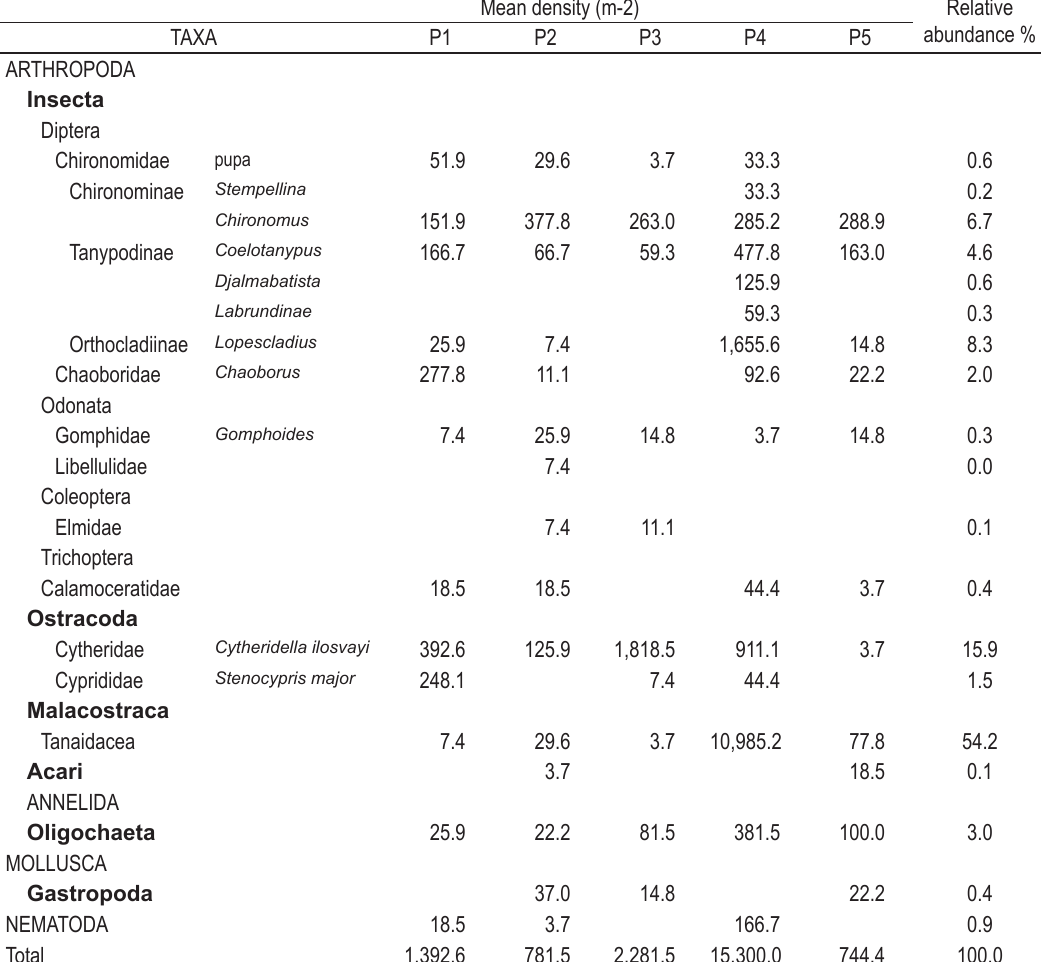
Table 2. Taxonomic composition, mean density of organisms at each sample site and relative abundance of aquatic invertebrates found in the sediment of Peri lagoon during the three samples moments.